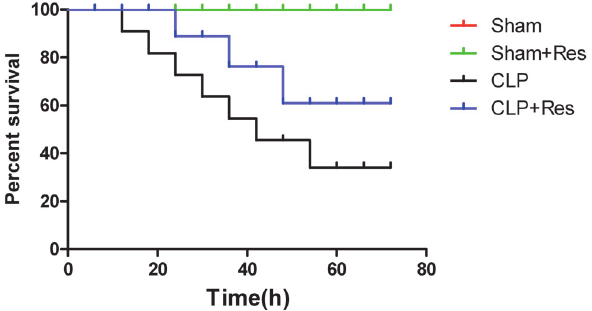
Fig. 1. Effects of resveratrol on survival rates of septic rats.